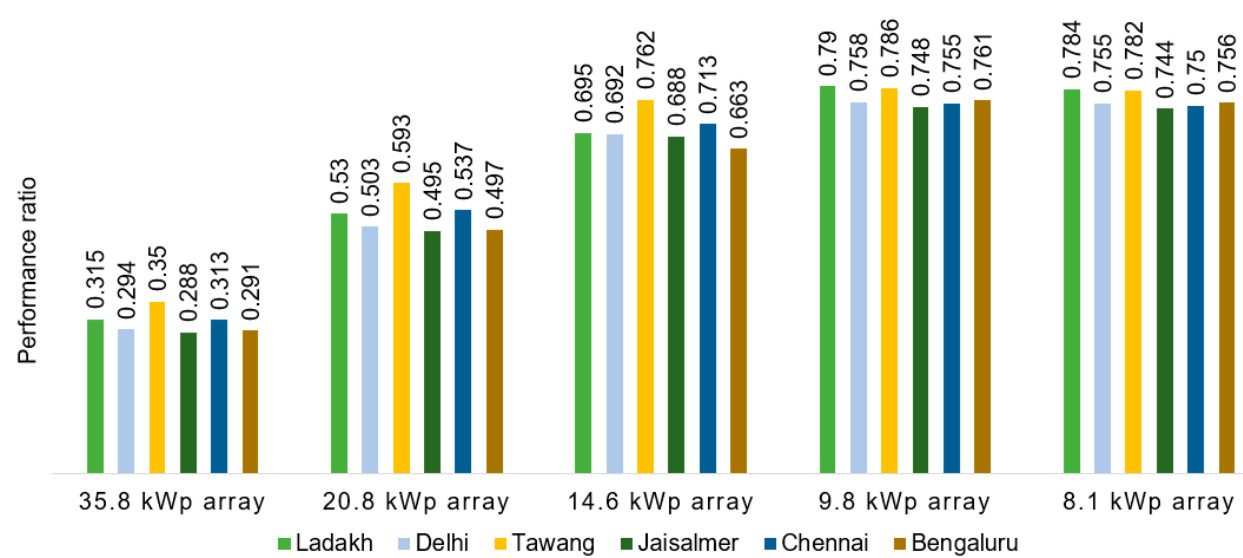
Figure 8. Performance ratio (PR) for different array sizes in all six cities .